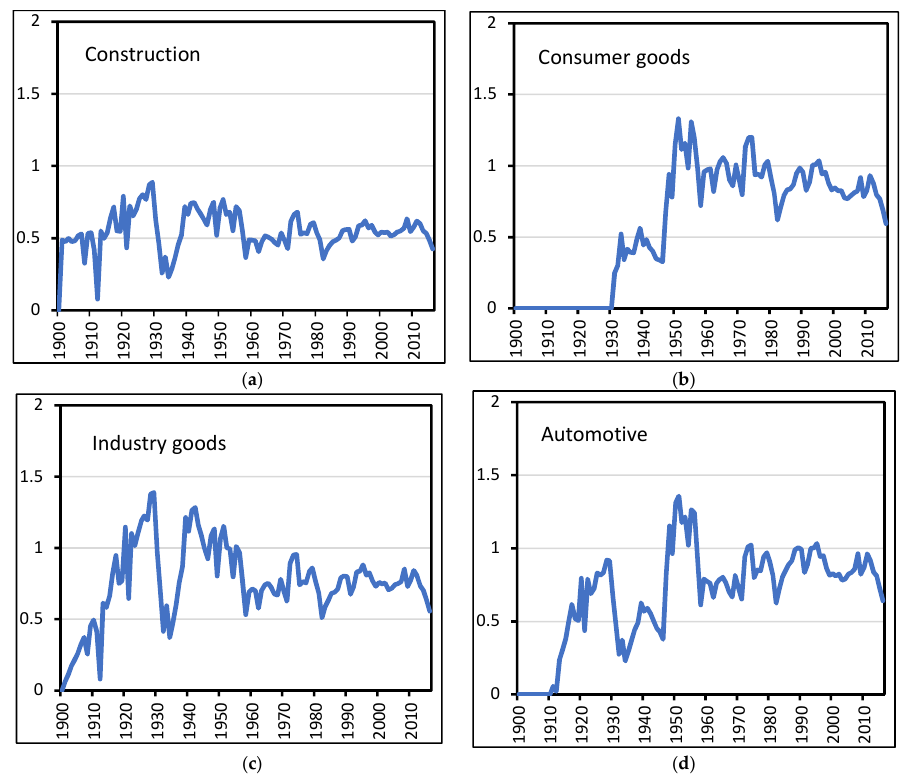
Figure 5. Apparent recovery rates of steel 𝜂(𝑡) per industry sector in the U.S. between 1900 and 2016: ( a ) construction, ( b ) consumer goods, ( c ) industry goods, and ( d ) automotive sector.